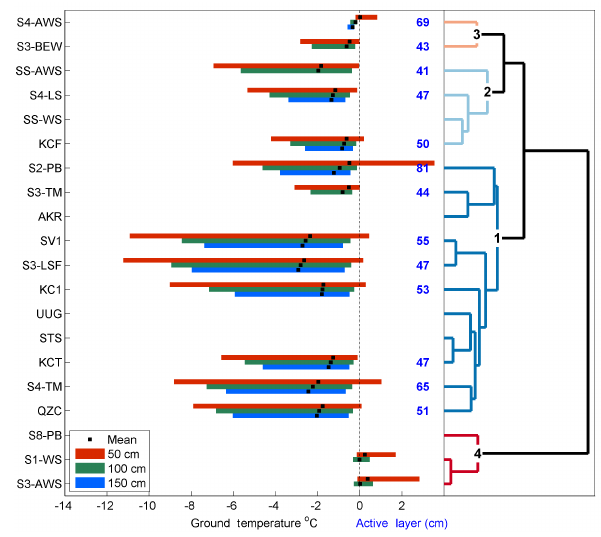
Figure 8. Annual summarized data for the period from 1 Au- gust 2012 to 31 July 2013. On the left is the annual mean (black squares) and range from daily averages (colored bars) for three depths from each site; in the center is the calculated active layer depth; on the right the cluster analysis dendrogram for refer- ence.